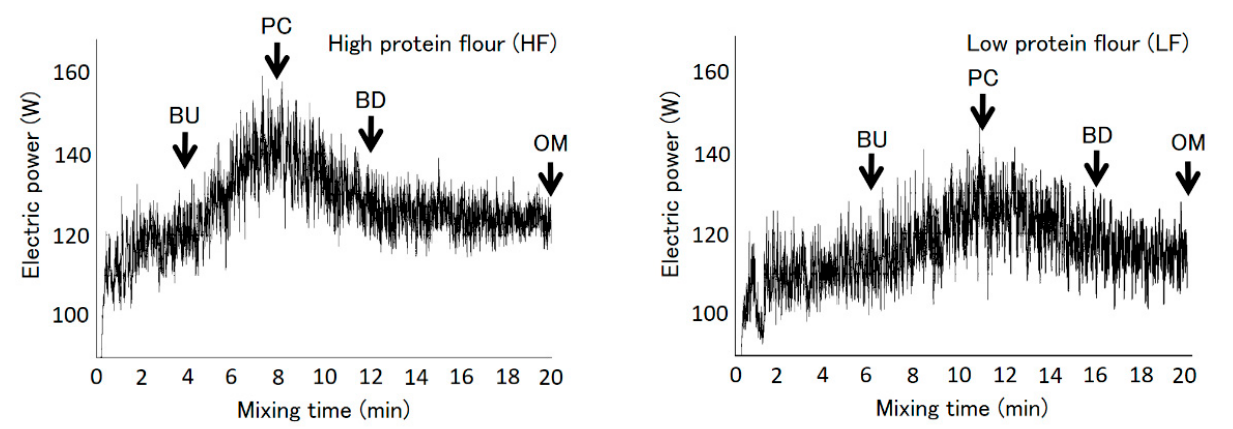
Figure 1. Dough mixing curves for high-protein flour ( left ) and low-protein flour ( right ). Arrows indicate sampling points. BU, PC, BD and OM indicate buildup, peak consistency, breakdown, and overmixing, respectively. Reprinted from Iwaki et al. 2020 [21].